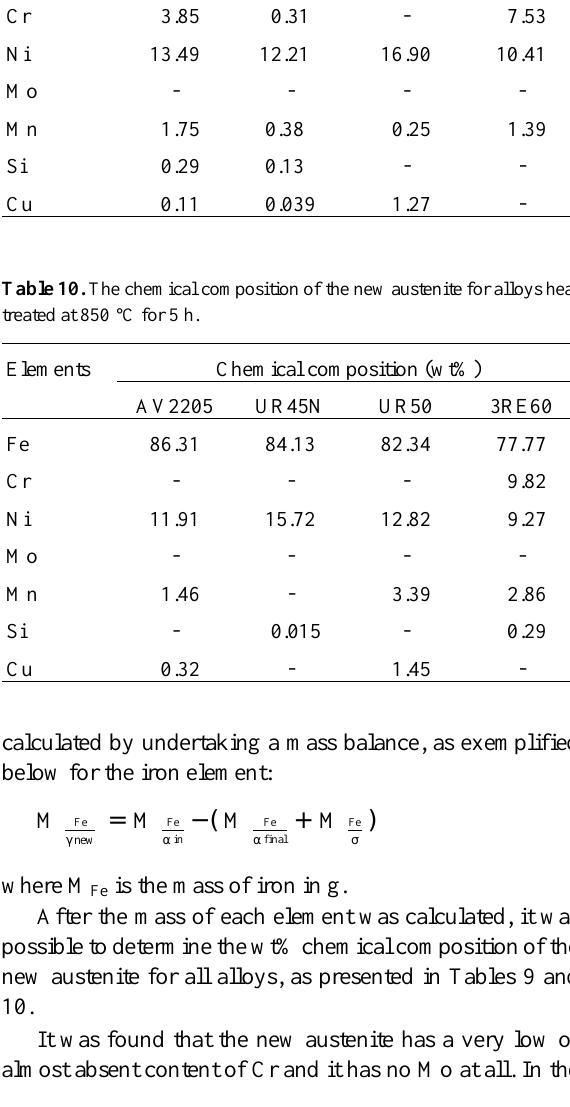
Table 11. The pitting potentials of alloys solution annealed and heat- treated at 850 °C for 1 h and 5 h.